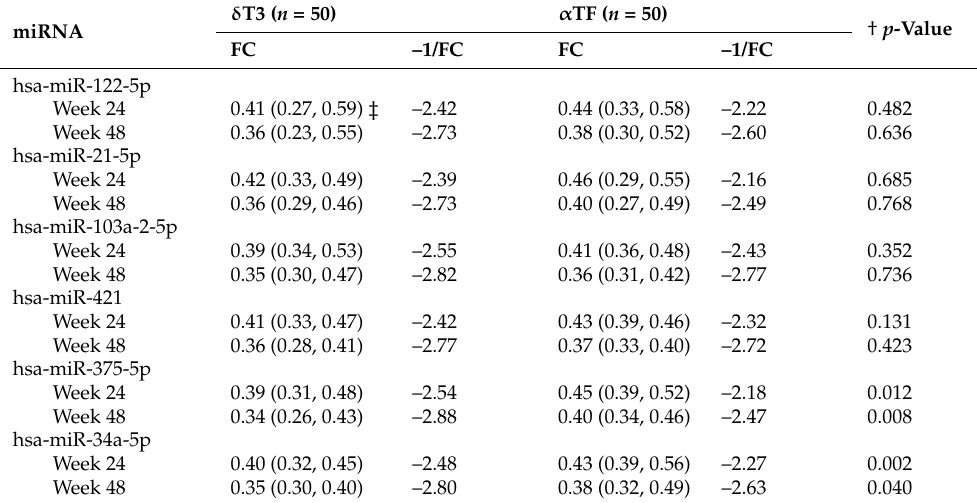
Table 3. Fold changes in microRNA expression from baseline to 24 and 48 weeks of intervention.